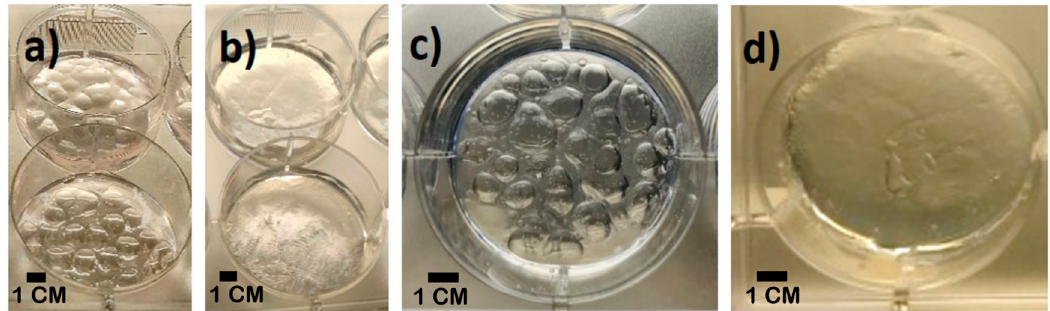
Figure 2. Images of EWA made by two techniques, and the small bubbles in EWA. The EWA images were acquired before ( a , c ) and after ( b , d ) the improved crosslinking technique. ( c ) and ( d ) show one well from the 6-well plate where the low quantity of micro and macro bubbles/pit is observed on the improved method ( d ).